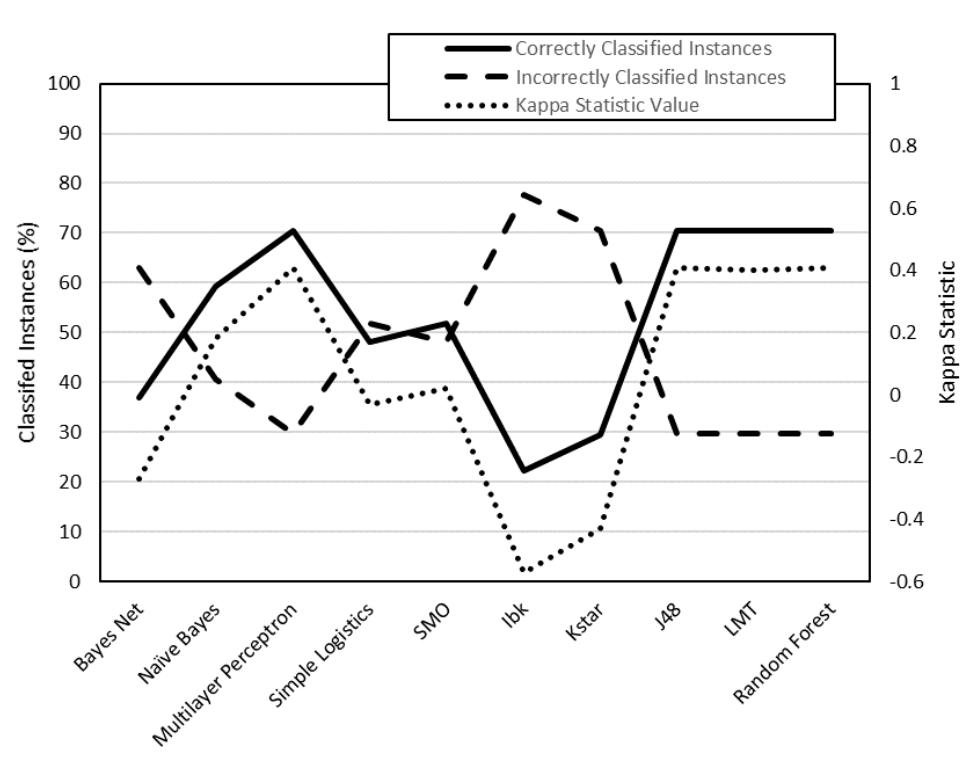
Table 8. Strenght of concordance for kappa statistic.